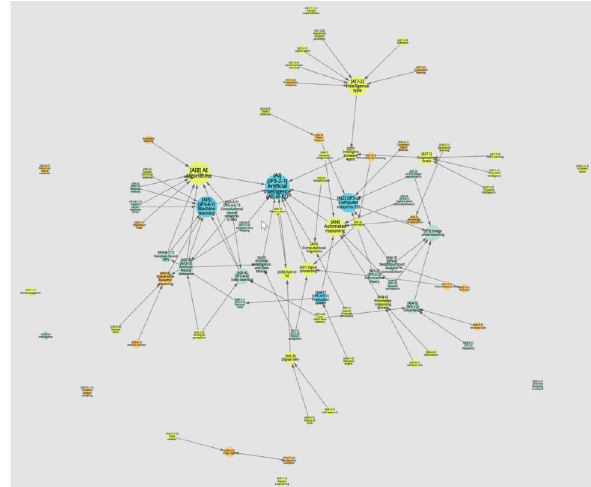
Figure 4 . Separate AI cluster with 79 AI concepts. For the purpose of further integration, the concepts are marked with different colours: Yellow: New AI concepts; Blue: Existing concepts, which need content change; Orange: Existing concepts to be checked Green: Existing concepts, which do not need a change of content.